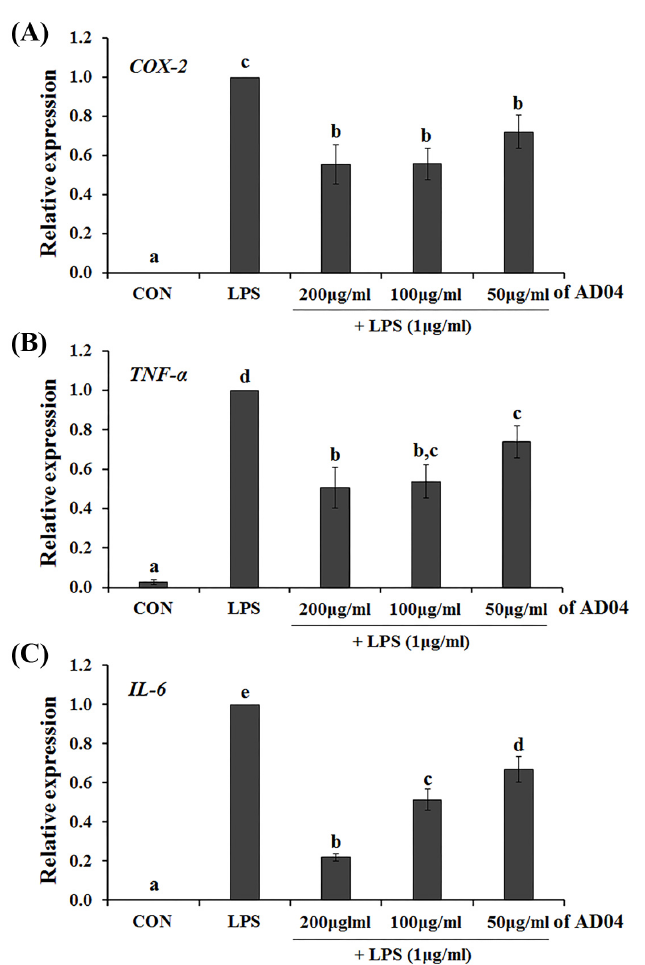
Fig. 4: Effect of BuOH fraction (AD04) on the expression of LPS-induced COX-2 , TNF-α , and IL-6 . Total RNA was isolated from RAW264.7 cells treated with or without LPS in the presence of AD04. The ex- pression levels for each gene in different samples were calculated relative to its expression in LPS-stimulated RAW 264.7 cells. Data are expressed as the mean ± SD of three independent experiments. Mean separation within columns by Duncan’s multiple range test is at the 0.05% level.